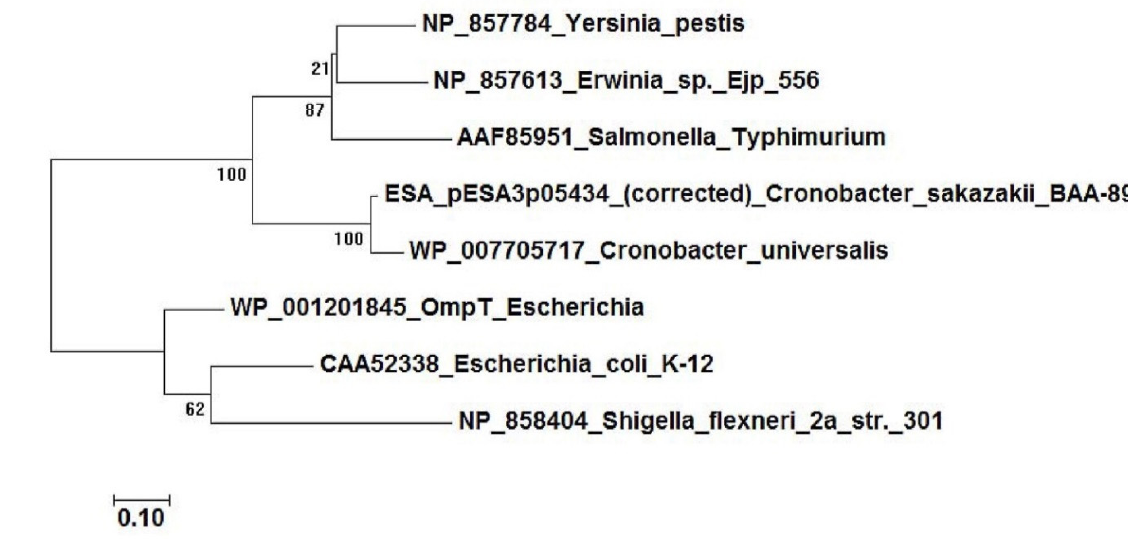
Figure 2. Phylogenetic tree of the homologs of omptin, Cpa. The NCBI accession numbers of the proteins sequences used in the figure are as follows: Yersinia pestis, Pla (plasminogen activator, NP_857784); S. enterica Typhimirium, PgtE (outer membrane serine protease, AAF85951); Erwinia , PlaA (plasmid, NP_857613); C. sakazakii BAA-894, Cpa (plasmid, ESA_pESA3p05434); C. universalis NCTC 9529, Cpa (omptin family outer membrane protease, WP_007705717); E. coli , OmpT (outer membrane protease VII, AP_001210); E. coli, OmpP (outer membrane protease P, X74278); and Shigella flexneri , SopA (outer membrane protease, NP_858404). Forty-one amino acids were added to C. sakazakii Cpa protein in its N-terminal to correct the incomplete annotation of the protein in the GenBank record. The MUSCLE algorithm of the MEGA7 suite was used for multiple sequence alignment. Phylogenetic analyses were conducted in MEGA7 using the Maximum-Likelihood algorithm [77]. Three hundred nine amino acid positions across the protein were used for determining the distance between the homologs in the tree. Bar marker represents 0.1 amino acid differences. Confidence values given in the nodes were derived out of bootstrap test consisting of 500 iterations.